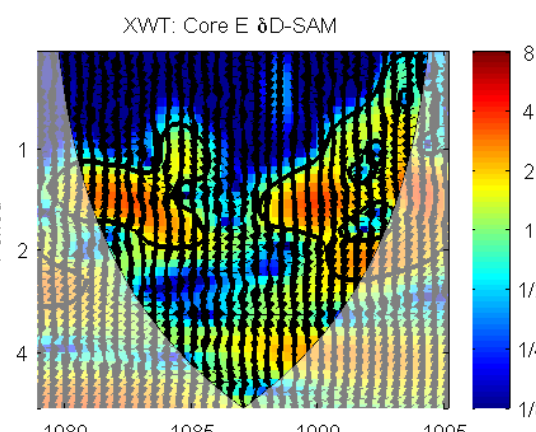
Figure A.1. Top) Core E δ D and Core E Net Accumulation XWT from 1657-1995. Middle) Core E δ D and Ni˜no 3.4 XWT from 1950-1995. Bottom) Core E δ D and SAM XWT from 1979-1995.